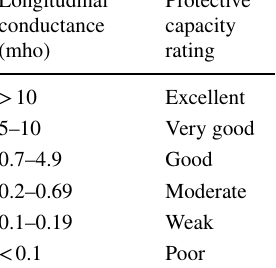
Table 2 Longitudinal conductance/protective capacity rating (Ogungbemi et al.